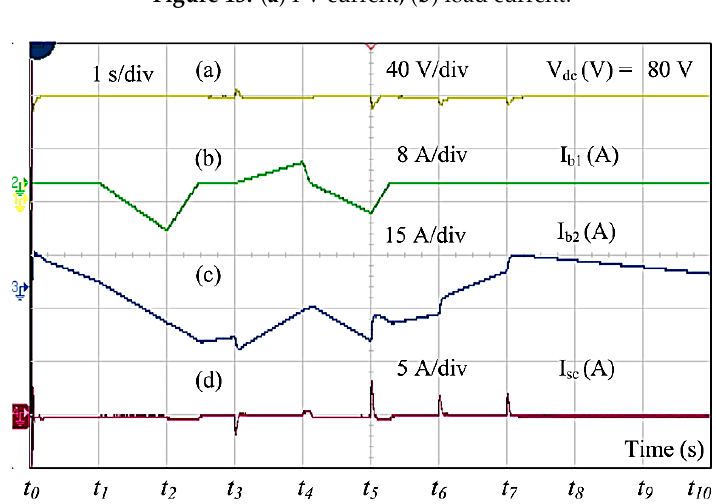
Figure 13. ( a ) PV current, ( b ) load current.